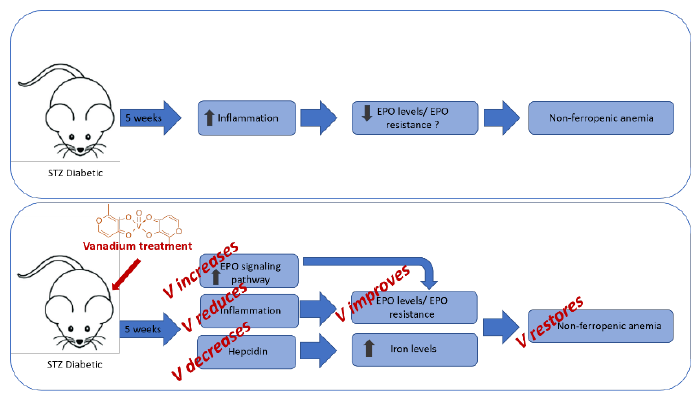
Figure 3. The suggested hypothetical mechanism.